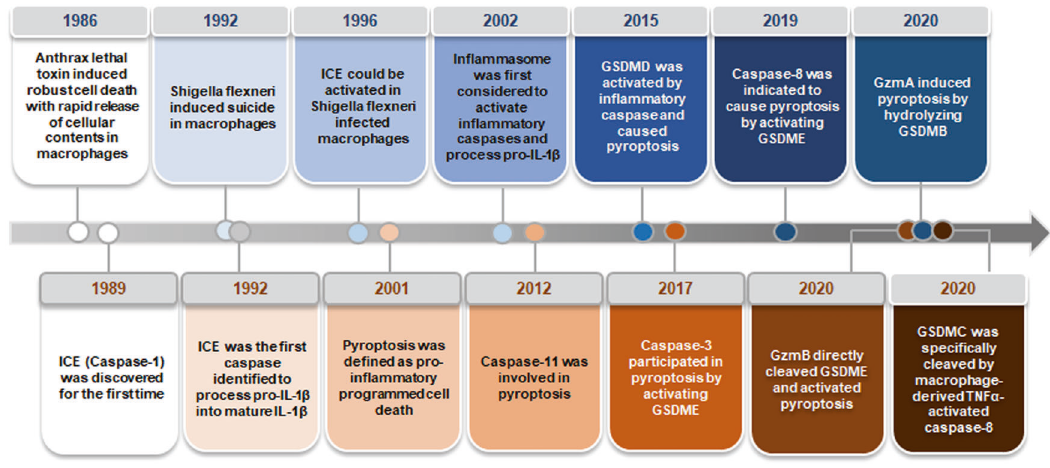
Fig. 1 The timeline of